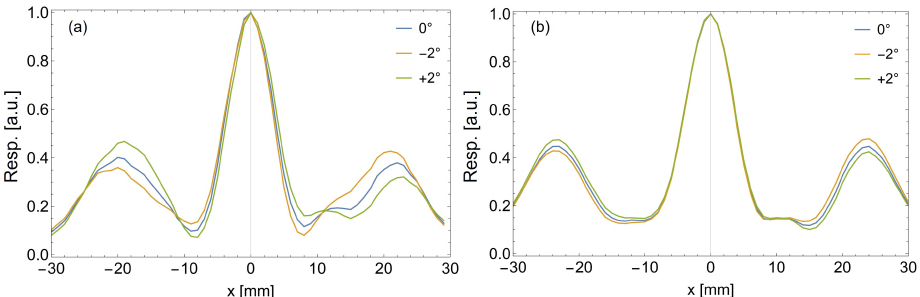
Figure 8. Cross sections along the spots measured in the focal plane of the f = 700 mm structure with ( a ) QOD and ( b ) WR51 detectors. The blue, orange and green lines denote the configurations with the detectors placed at an angle of 0 ◦ , + 2 ◦ and − 2 ◦ , respectively. These geometries reflect the situations in which the detectors face the center of the lens from the positions of M, L and R focal